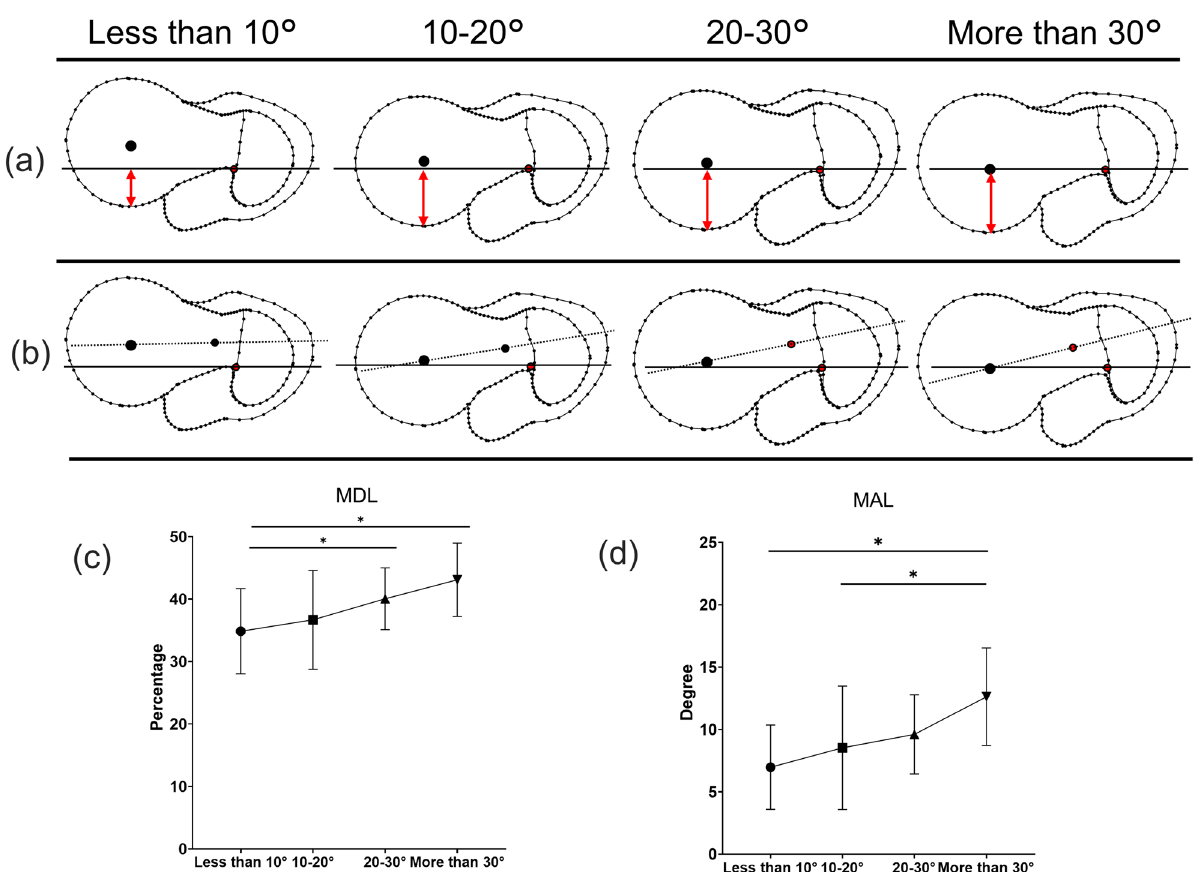
Figure 6. The shapes of the proximal femur according to the native anteversion, where ( a ) is the passing point of the native anteversion at the femoral head (MDL), and ( b ) is the angle between the native anteversion and head-neck axis (MAL). ( c ) and ( d ) show the details and ANOVA results of MDL and MAL,